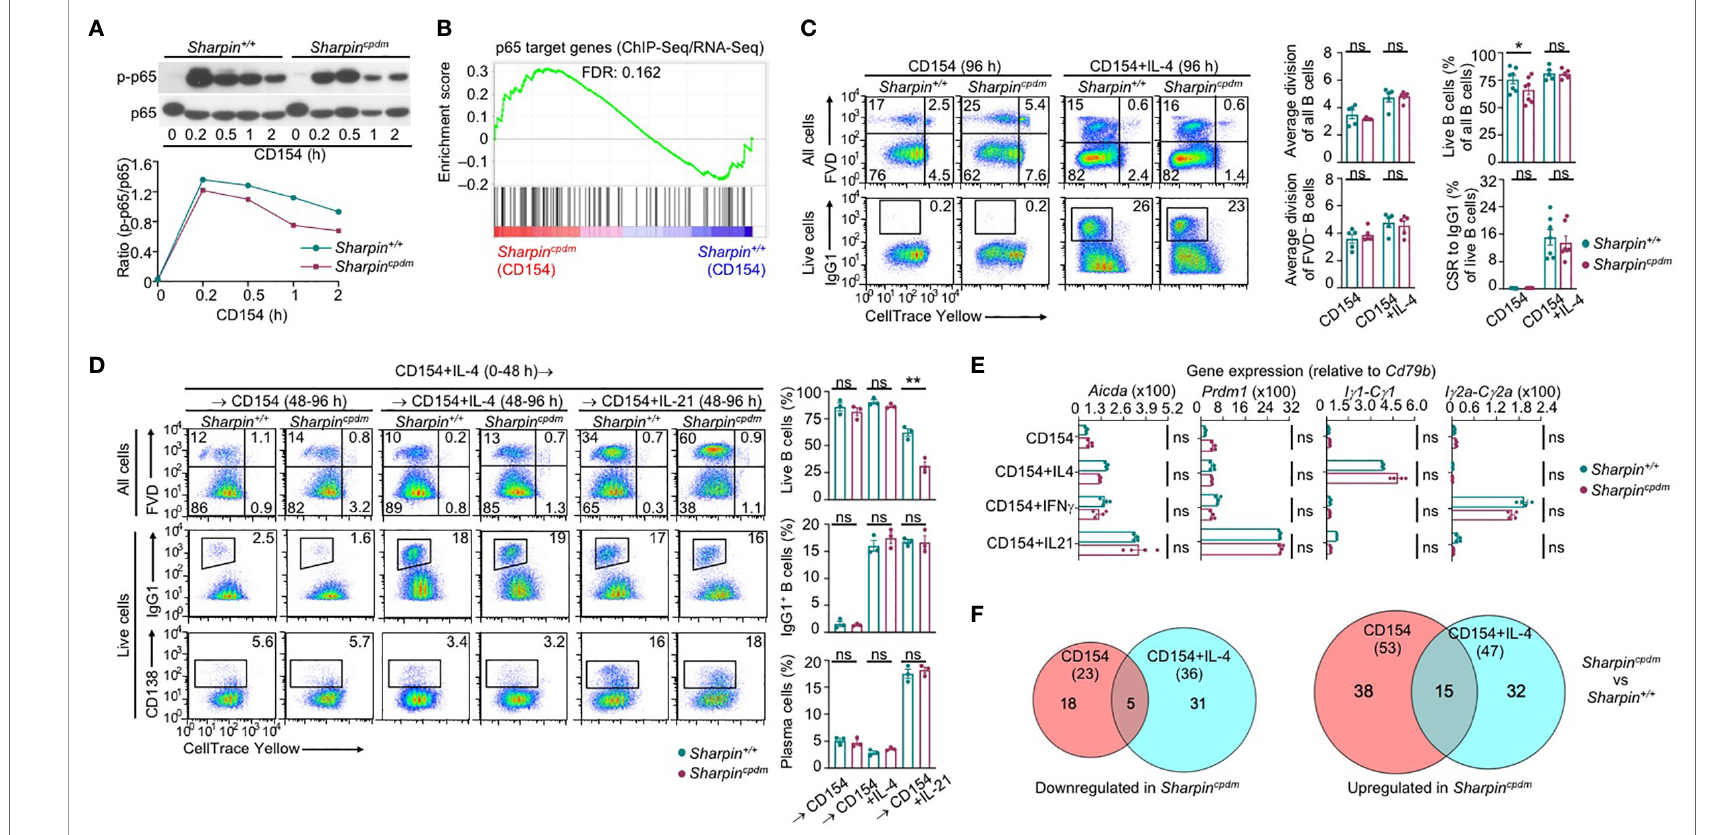
FIGURE 4 | SHARPIN is dispensable for activation, proliferation, survival, and differentiation of B cells stimulated with CD154. (A) Immunoblotting of phosphorylated p65 and total p65 protein levels in Sharpin +/+ and Sharpin cpdm B cells after stimulation by CD154 for the indicated time. Representative of two independent experiments. (B) GSEA analysis of differentially expressed genes (DEGs) in Sharpin +/+ and Sharpin cpdm B cells stimulated with CD154 for 24 h for the enrichment of p65 target genes (RNA-Seq data were pooled from two independent experiments). (C) Flow cytometry analysis of proliferation, survival, and CSR to IgG1 in Sharpin +/+ and Sharpin cpdm B cells stimulated with CD154 or CD154 plus IL-4 for 96 h. (D) Flow cytometry analysis of survival, CSR to IgG1 and plasma cell differentiation in Sharpin +/+ and Sharpin cpdm B cells after stimulation fi rst with CD154 plus IL-4 for 48 h, washed, and then with CD154, alone or plus IL-4 or IL-21, for 48 h. (E) qRT-PCR analysis of gene expression, as indicated, in B cells stimulated with CD154, alone or plus IL-4, IFN- g or IL-21, for 48 h. (F) The numbers of DEGs ( p values < 0.01, absolute value of log 2 FC > 1) between Sharpin +/+ and Sharpin cpdm B cells after stimulation with CD154 or CD154 plus IL-4 for 24 h, as depicted by Venn diagram. Data were pooled from two independent RNA-Seq experiments. * p <0.05; ** p <0.01;